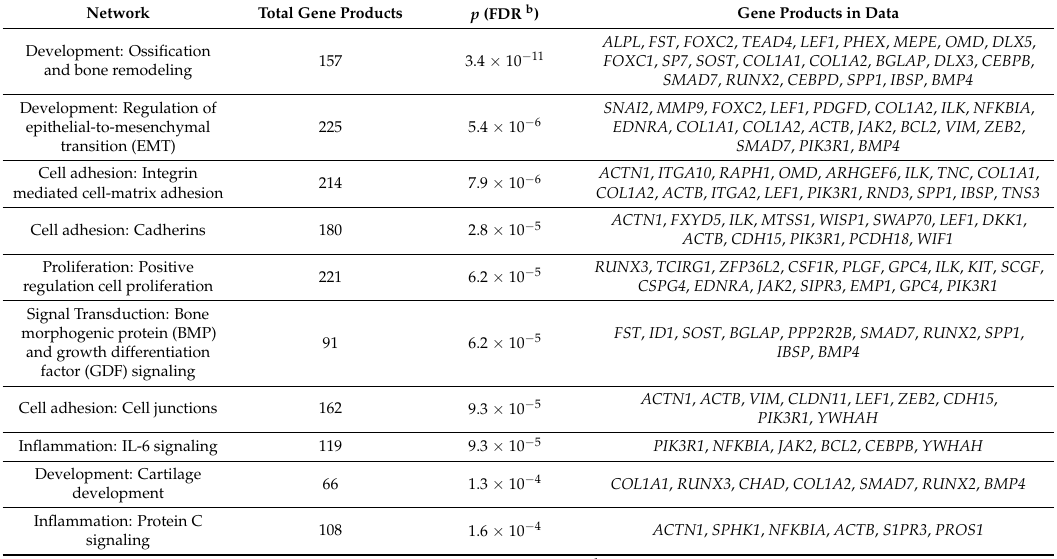
Table 2. The top 10 enriched process networks positively associated with bone cell activity a in prostate cancer bone metastasis. Network Total Gene Products p (FDR b ) Gene Products in